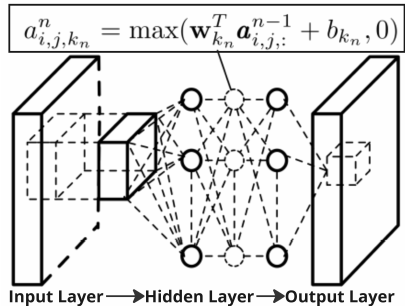
Figure 11. The CNN architecture.